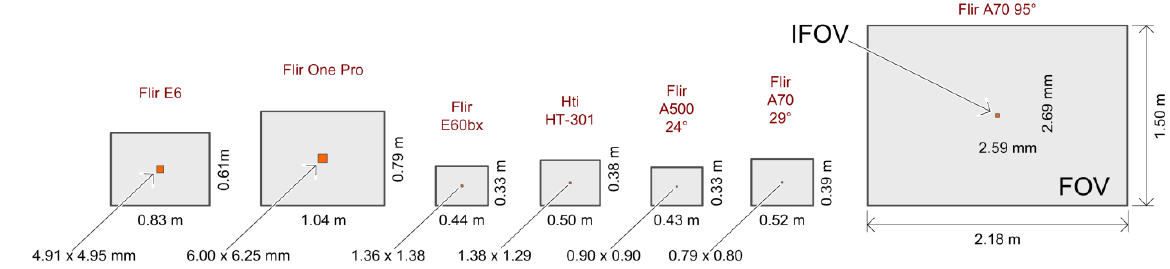
Figure 20. Visual comparison of FOI and IFOV of individual cameras set 1 m from object.